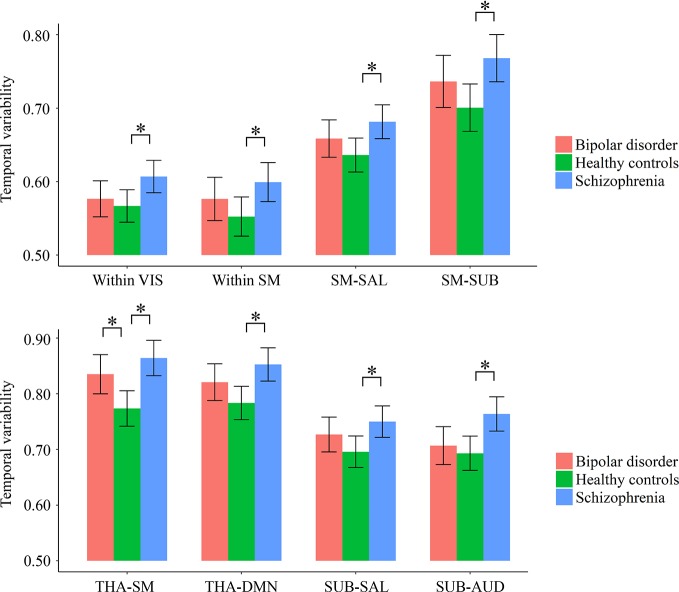
Group differences in the temporal variabilities of intra-network and inter-network FC patterns. The error bars present the 95% confidence intervals, and the marks “*” indicate significant between-group differences with corrected p < 0.05. AUD, auditory network; DMN, default mode network; FC, functional connectivity; SAL, salience network; SM, sensorimotor network; SUB, subcortical network; THA, thalamus; VIS, visual network.